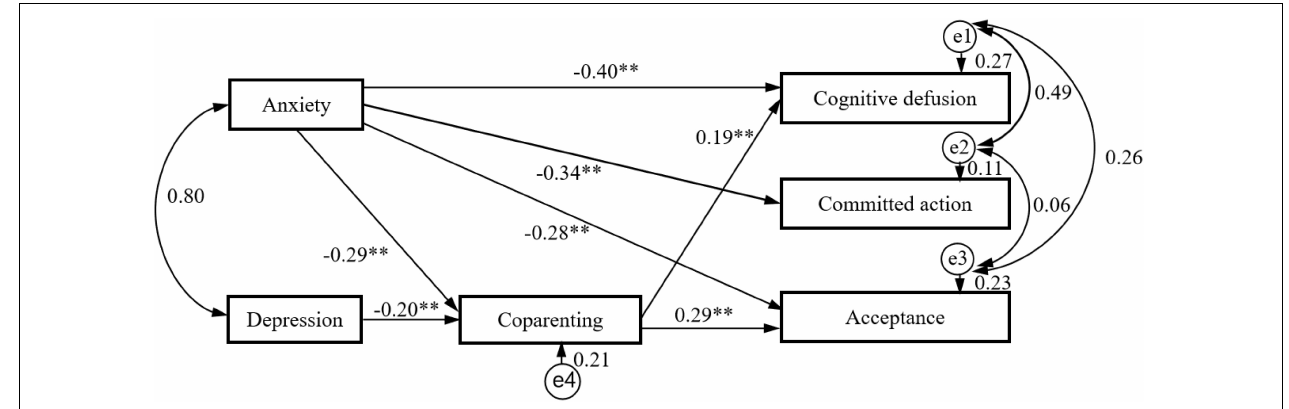
FIGURE 1 | Results of mediation path analysis showing the relationships between anxiety, depression, and parental psychological flexibility with coparenting as a mediator. ∗∗ P < 0.01.